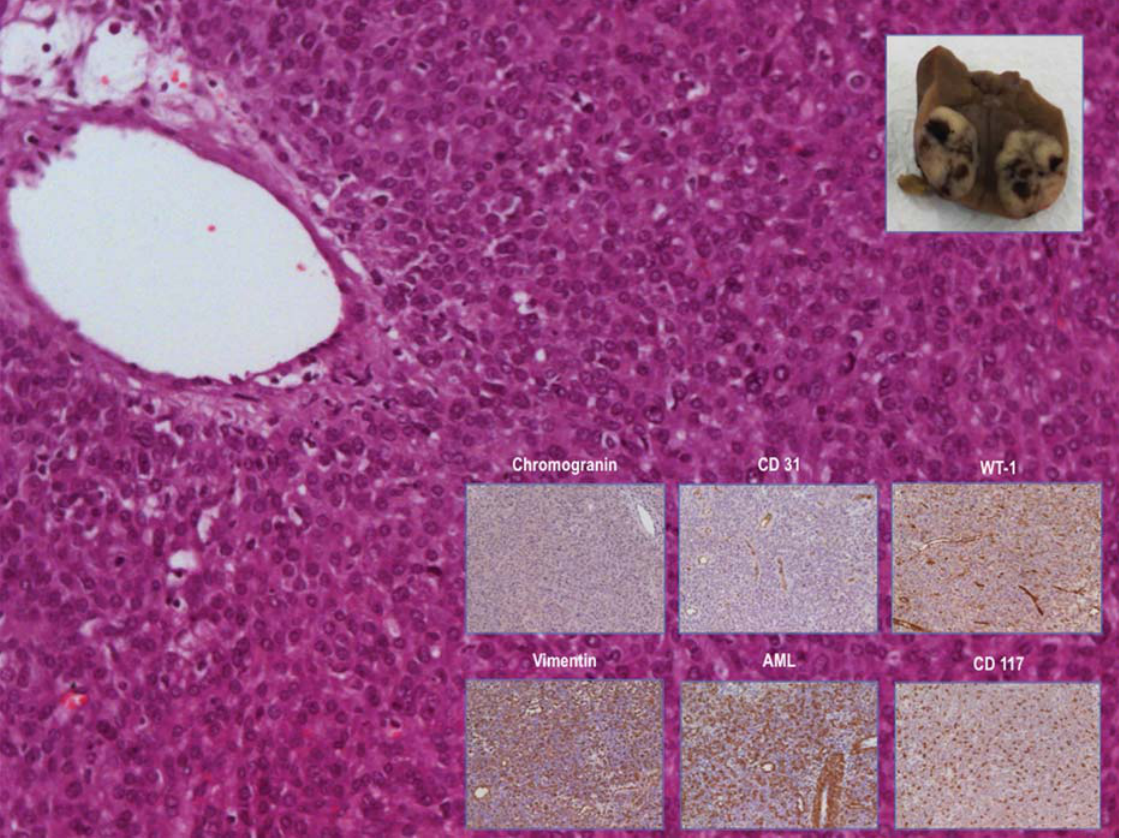
Figure 2 - Histological examination showing microscopic characteristics of juxtaglomerular tumor cells (Eosin and Hematoxylin): tumor cells with mild nuclear atypia, inconspicuous nucleoli and pale ill-defined cytoplasm; Immunohistochemical study negative for Chromogranin A, WT-1, and CD 31; positive for AML (areas), vimentin (focally), and CD 117